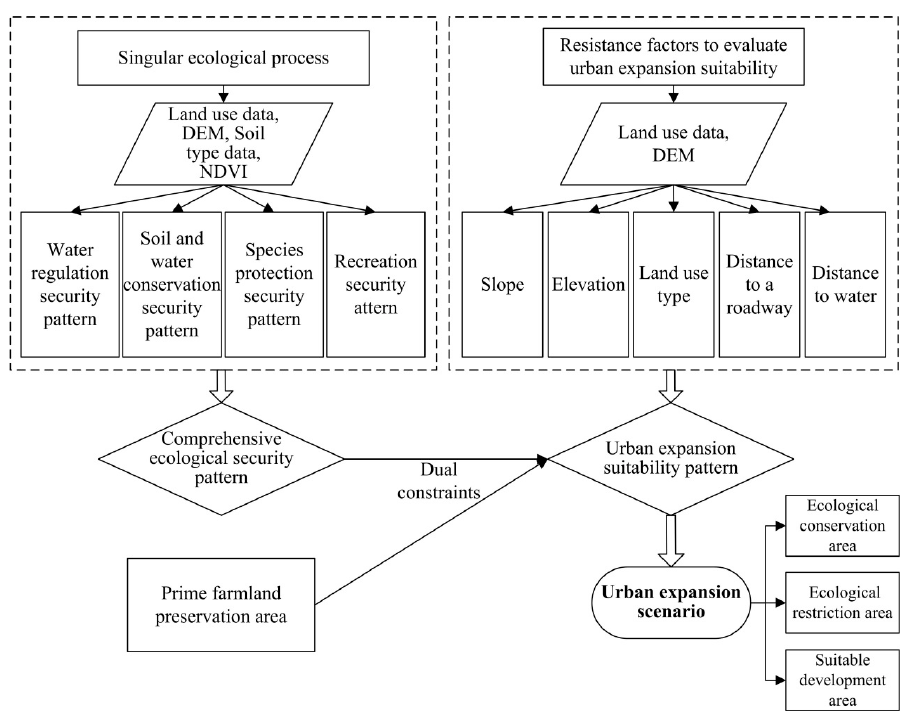
Figure 2. Technology route.